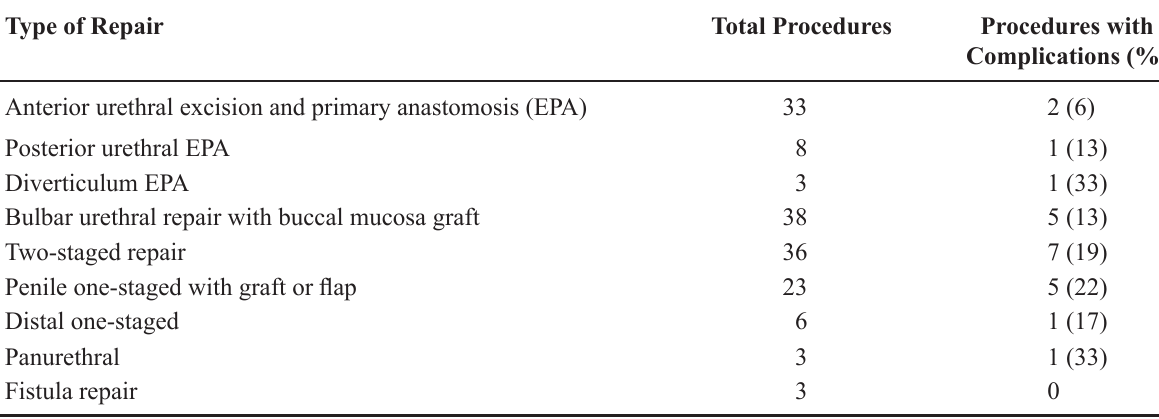
Table 1 – Complication rate by type of urethral stricture repair. Type of Repair